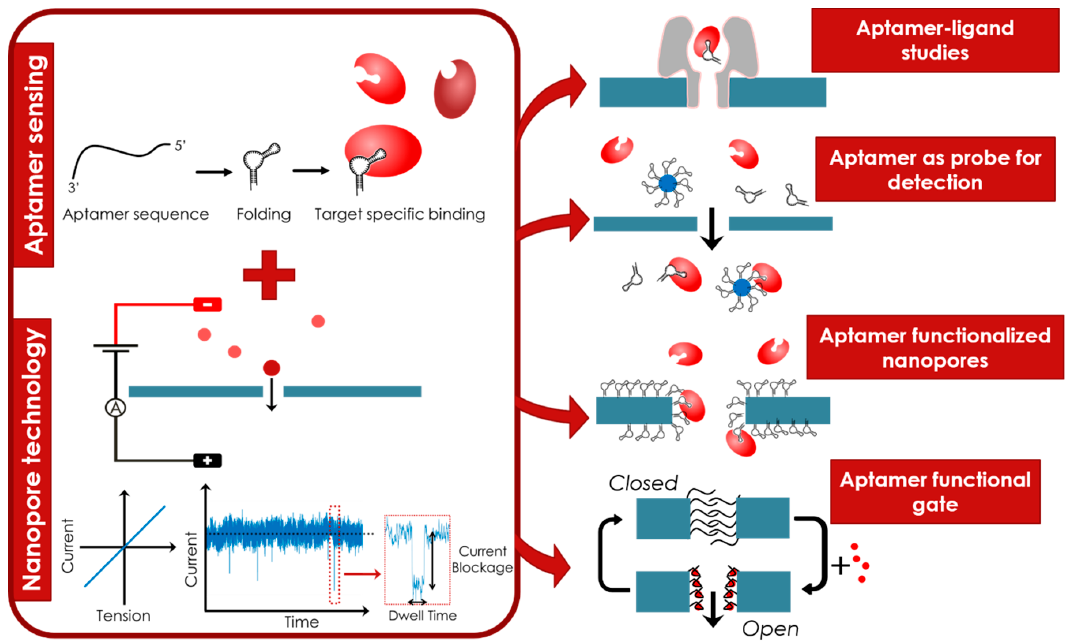
Figure 11. Schematic summary of the review. The winning combination of aptamer sensing with nanopore technology opens the door to fundamental studies of aptamer-ligand structures, target detection through recognition by aptamers in solution or functionalized in the nanopore aperture and finally to functional nanopores due to the conformational switching of aptamers.